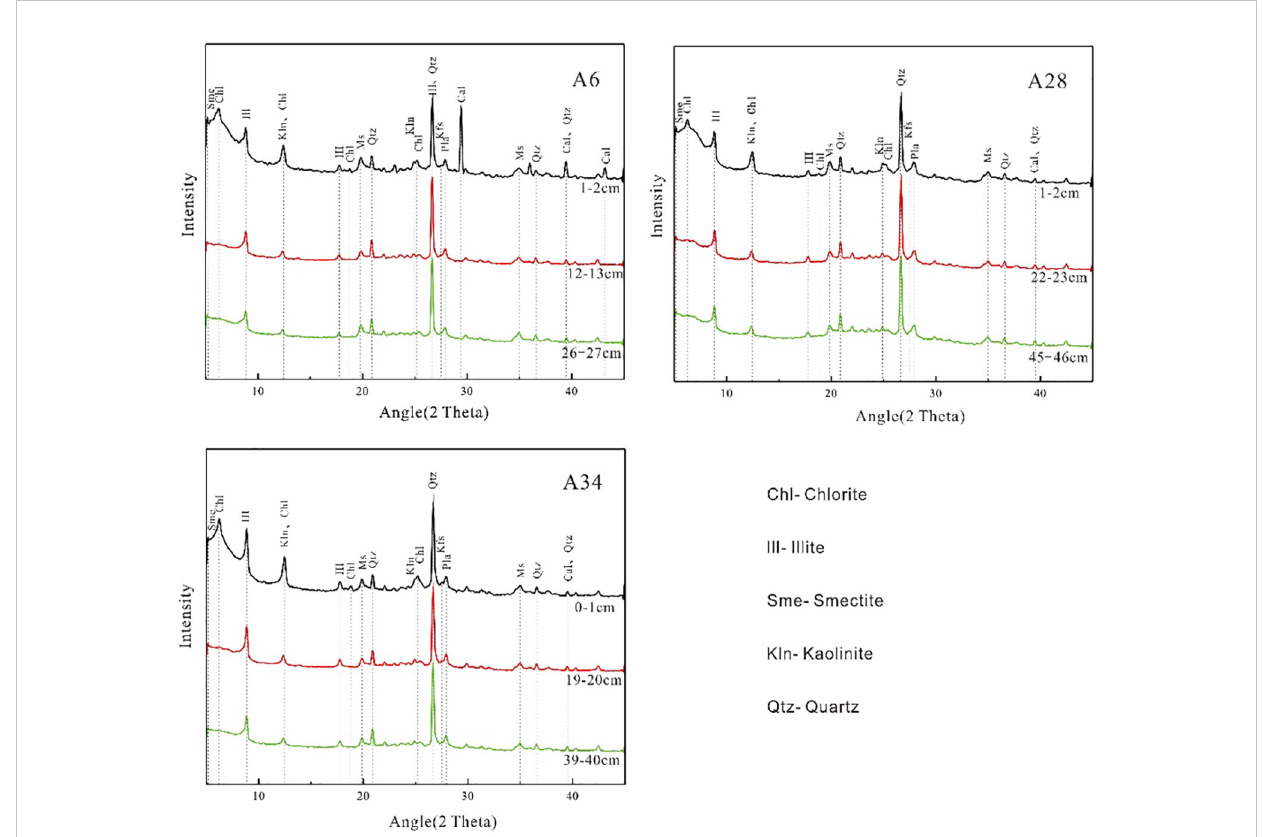
FIGURE 3 Diffraction spectrum of clay minerals in core sediments from stations A6, A28 and A34.